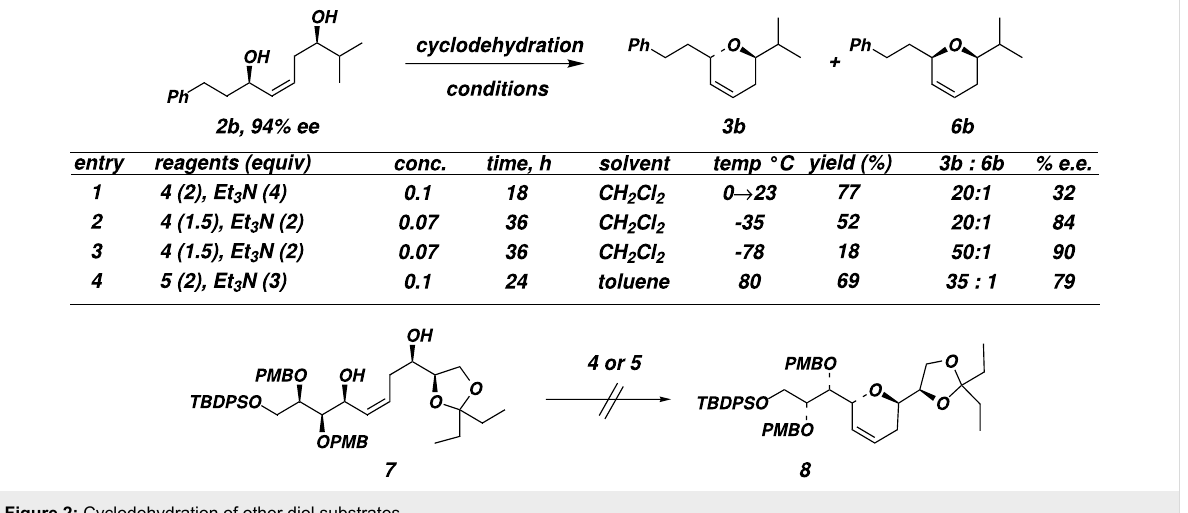
Figure 2: Cyclodehydration of other diol substrates